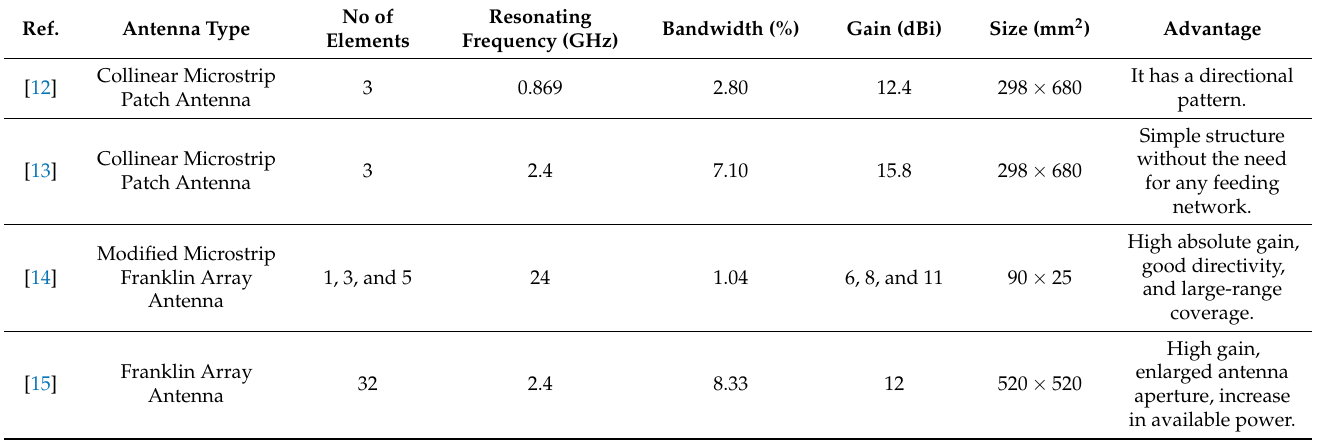
Figure 17. The radiation pattern for the proposed antenna at frequencies of ( a ) 22.7 and ( b ) 34.9 GHz. Table 2. Comparison of various antenna performance